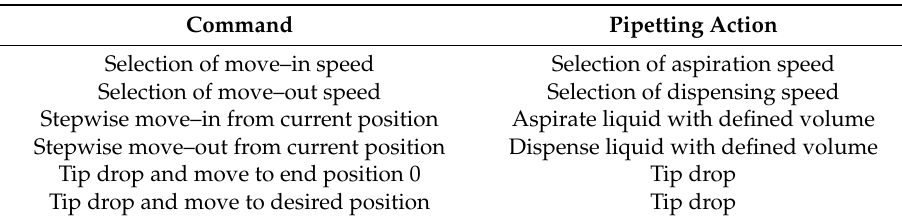
Table 3. Pipetting commands and resulting pipetting